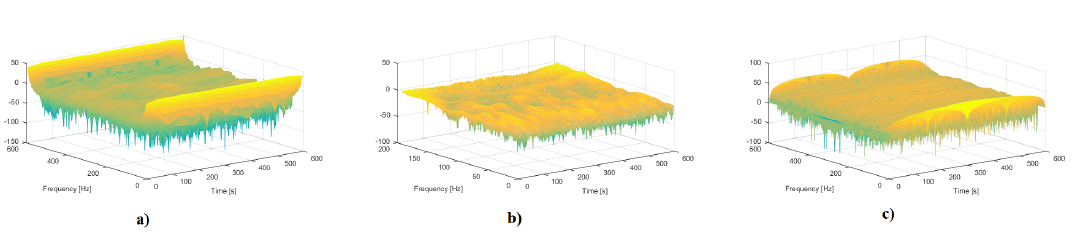
Figure 10. Time-frequency (TF) representations of measured pitch responses: ( a ) Short-time Fourier transform (STFT), ( b ) Continuous wavelet transform (CWT) and ( c ) Wigner-Ville distribution (WVD).